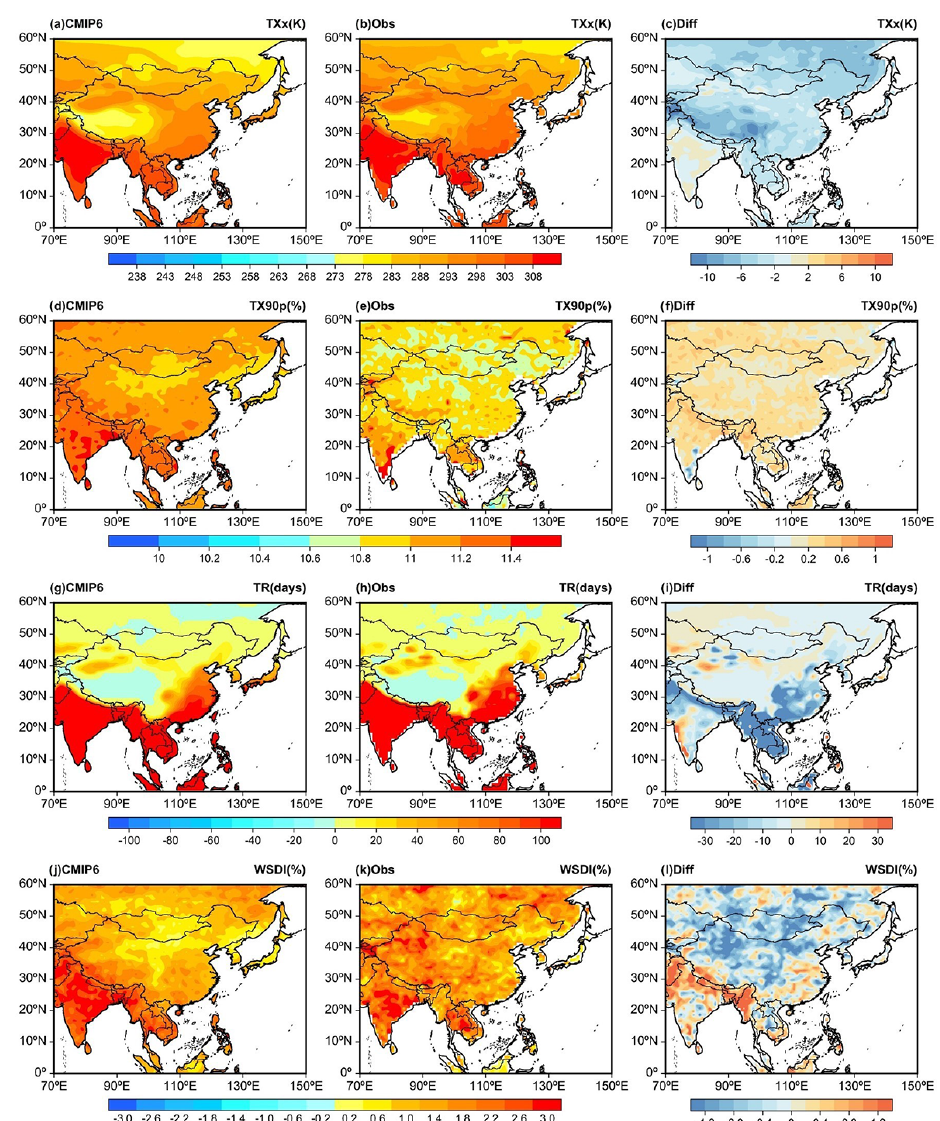
Figure 2. The annual mean of the hottest day (TXx), warm days (TX90p), tropical nights (TR), and warm-spell duration (WSDI) over the study area during 1995–2014 for the CMIP6 multi-model mean ( a, d, g, j ) and gridded observations ( b, e, h, k ). The right column ( c, f, i, l ) represents difference between CMIP6 and observations, so the red area in this column indicates that the model is